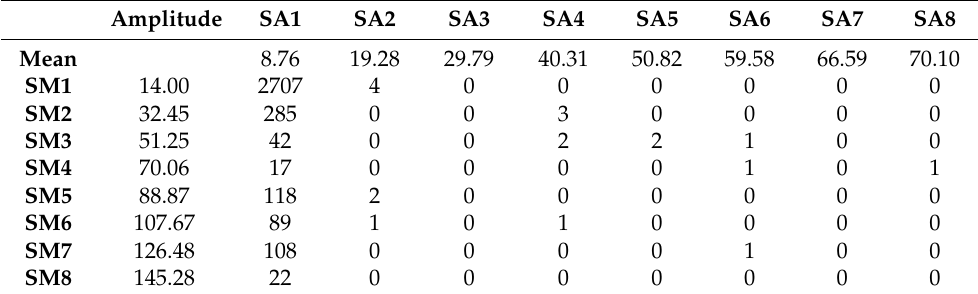
Table 3. Load spectrum compiled based on rain flow extrapolation method. (SA1-8 and SM1-8 respectively represent the eight levels of stress amplitude and mean stress).